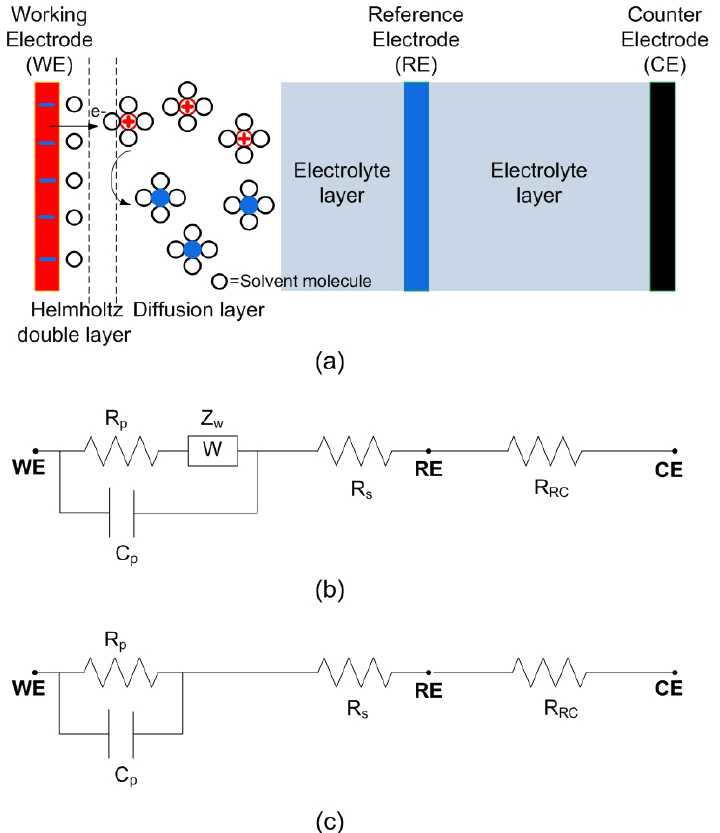
Figure 2. Modeling of the electrochemical cell. ( a ) Diagram of the processes at the electrode-electrolyte interface.The oxidants (red) with a positive charge diffuse toward the negatively charged electrode, accept electrons from the electrode at the interface, become the reductants (blue), and diffuse to the bulk of the solution. The dashed lines are the inner and outer Helmholtz planes, respectively. Equivalent circuit model (Randles equivalent circuit): ( b ) including the Warburg element that takes into account the controlled diffusion process in the low frequency region, and ( c ) without the Warburg